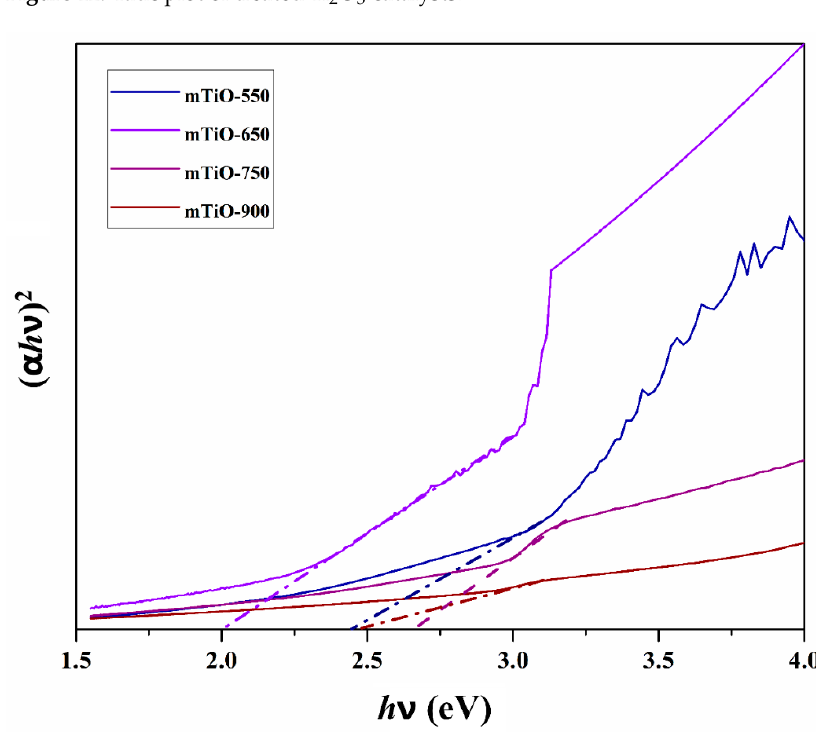
Figure 13. Tauc plot of treated mTiO